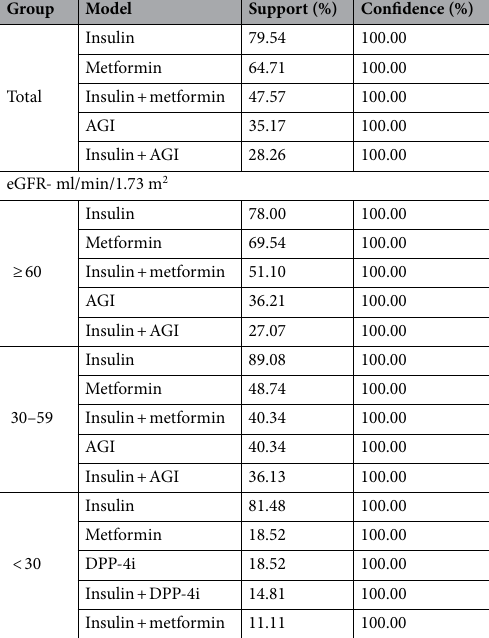
Table 2. Apriori algorithm of association rules. eGFR, estimated glomerular filtration rate; AGI, alpha- glucosidase inhibitors; DPP-4i, dipeptidyl peptidase-4 inhibitors.